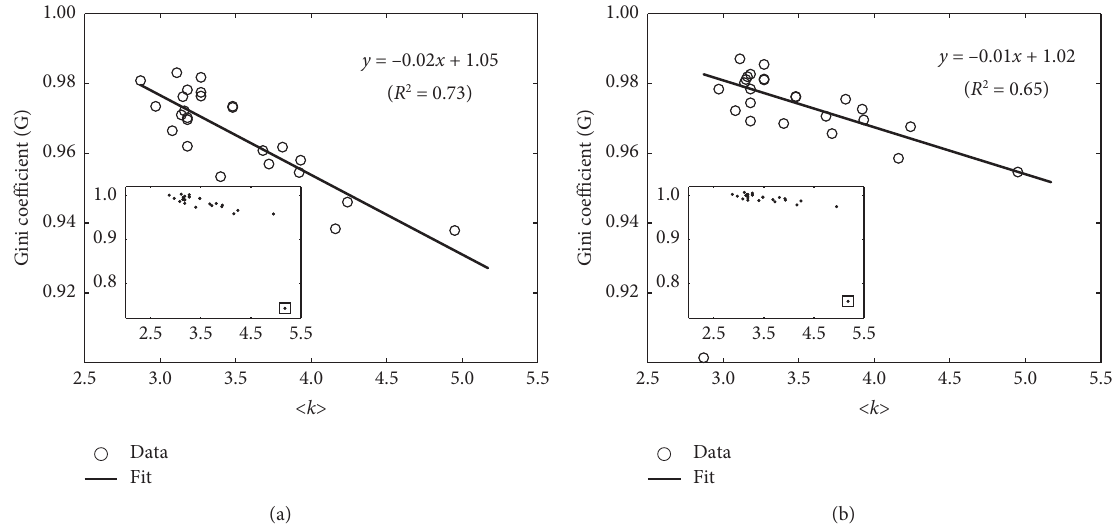
Figure 8: Modified Gini coefficients versus < k > measured by (a) degree-based attack ( G